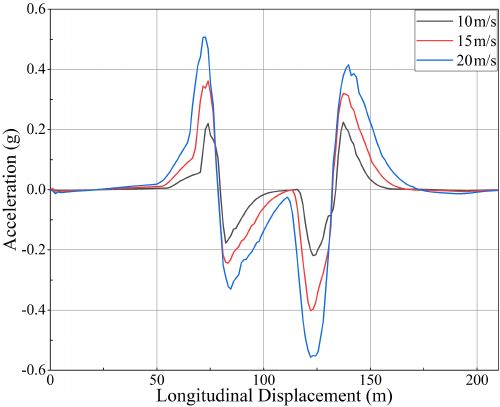
Figure 10. Acceleration at different